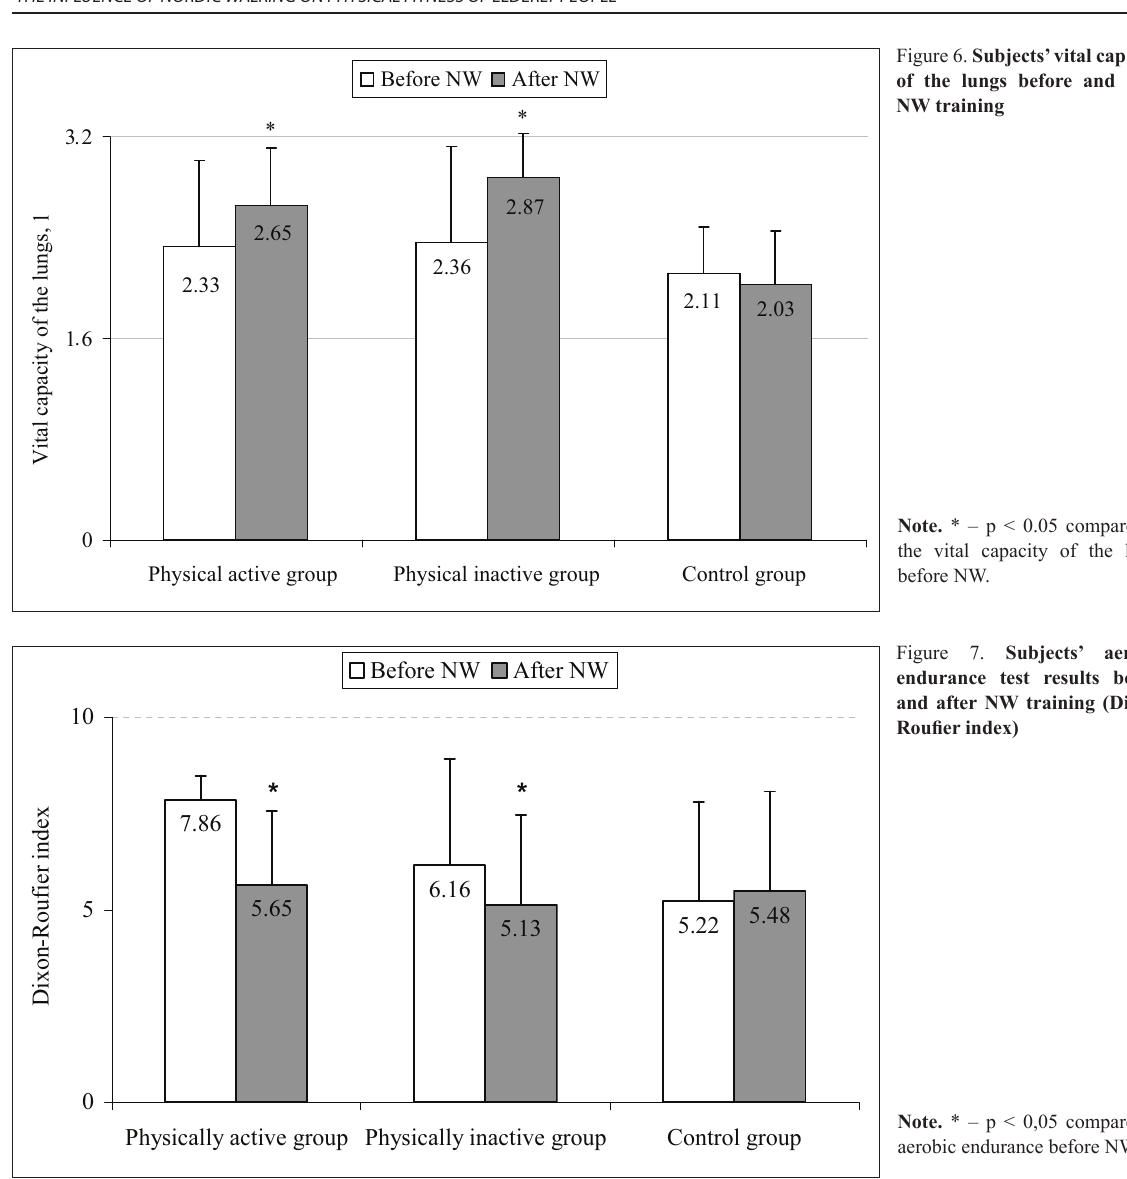
Figure 7. Subjects’ aerobic endurance test results before and after NW training (Dixon-Roufier index)